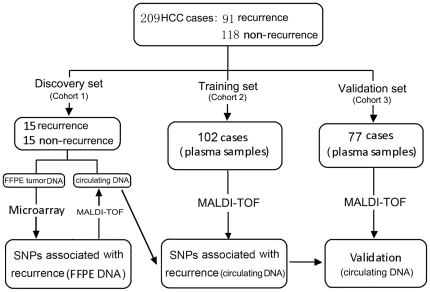
Study design.Discovery Set consisted of 30 patients randomly selected from recurrence patients and non-recurrence patients. Training Set consisted of 102 consecutive patients from January 2004 to December 2006, while Validation Set comprised 77 consecutive patients from January 2007 to June 2008. Thirty tumor DNA samples randomly selected from the recurrence and non-recurrence groups were hybridized on SNP microarrays. Signatures associated with tumor recurrence were selected and validated in circulating DNA using two other independent patient cohorts.